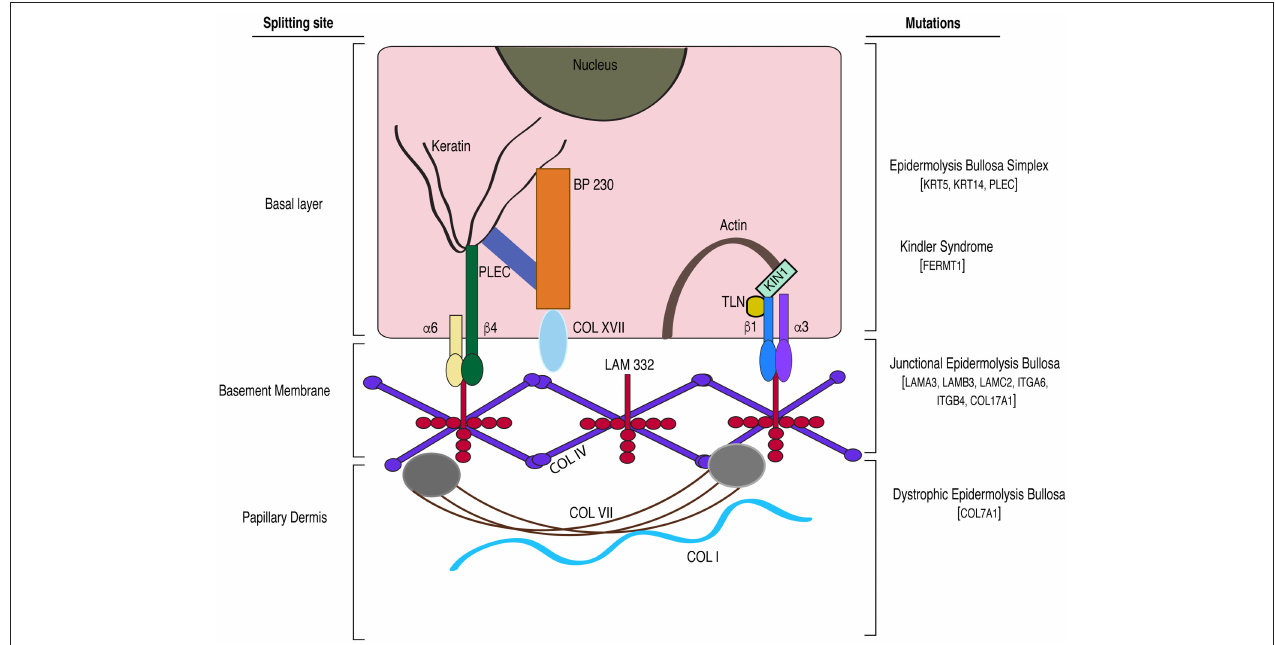
FIGURE 2 | A model depicting the gene mutations and the site of splitting associated with the different subtypes of epidermolysis bullosa. BP, bullous pemphigoid; TLN, Talin; α 6, integrin alpha 6; β 4, integrin beta 4; α 3, integrin alpha 3; β 1, integrin beta 1; LAM 332, laminin-332 protein; PLEC, plectin; COL, collagen; KIN1 (FERMT1), kindlin-1; KRT, keratin; ITG,